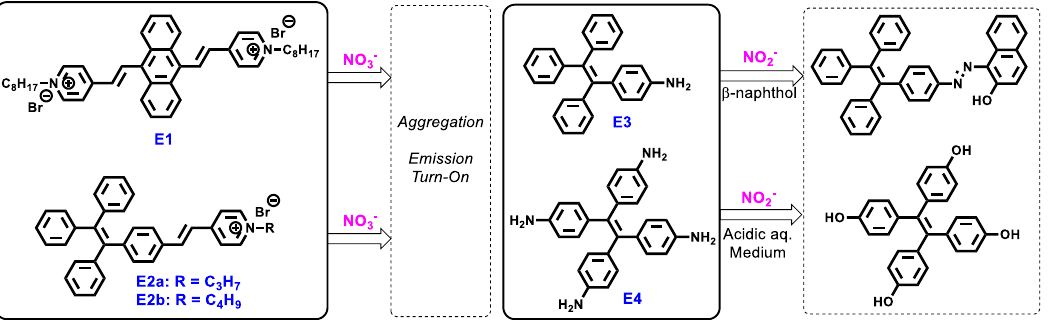
Molecules 2019 , 24 , 2711 31 of 45 Figure 10. ( a1 ) Schematic showing the binding of D13 with ATP, and ( a2 ) spectrofluorometric titration studies of D13 with ATP. Insert: photos showing the turn-on of green emission of D13 due to ATP. ( b1 ) Plot of maximum emission intensities of D14a – D14c (vs a control compound without boronic acid groups), with an increasing amount of ATP added; on the right, photos showing the corresponding emission changes. ( b2 ) Fluorescence spectra and photos showing emission turn-on for D14a due to selective recognition of ATP. Reproduced with permission from [112] and [113]. Copyright 2017, the Royal Society of Chemistry. Finally, Huang et al. reported a hydrogel system that is responsive to ATP. Hydrogel D15 was formed from the self-assembly between a TPE derivative containing two quaternary ammonium groups, and poly(sodium p -styrenesulfonate) [114]. Self-assembly caused RIR of the TPE moieties, leading to the hydrogel with bright blue fluorescence. When ATP was added, it competitively interacted with the two quaternary ammonium groups in the TPE derivatives via electrostatic interactions, disassembled the hydrogel and eventually quenched blue emission. The above process can however be reversed with addition of phosphatase, which hydrolyses ATP, thereby reinstating the formation of hydrogel D15 [114]. This type of hydrogel is biocompatible and could enter cell cytoplasm for biosensing of ATP in HEK293 cell lines. 6. Sensing of Nitrogen-Containing Oxoanions